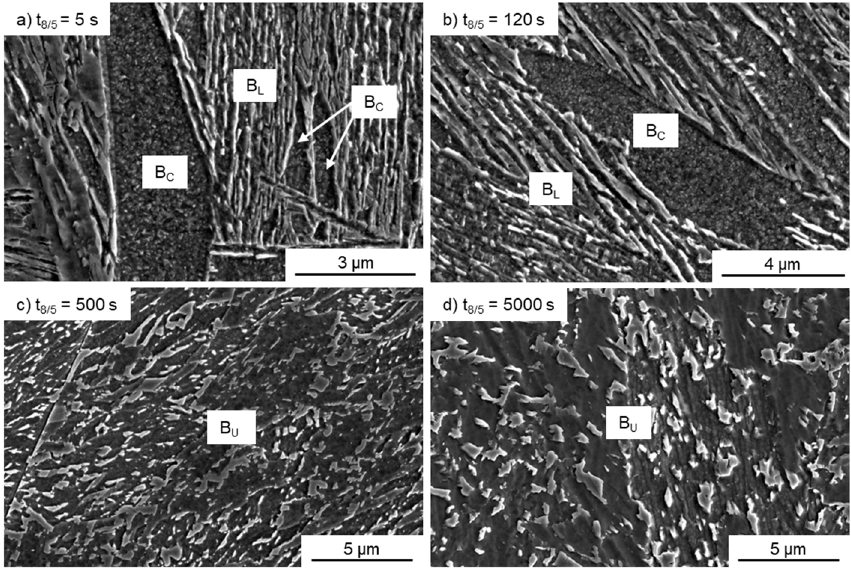
Figure 15. SEM images of the microstructure of the dilatometer specimens heated to 1200 °C for 5 min and cooled with different t 8/5 -times of ( a ) 5 s; ( b ) 120 s; ( c ) 500 s; and ( d ) 5000 s showing lower bainite (B L ), coalesced bainite (B C ) and upper bainite (B U ).